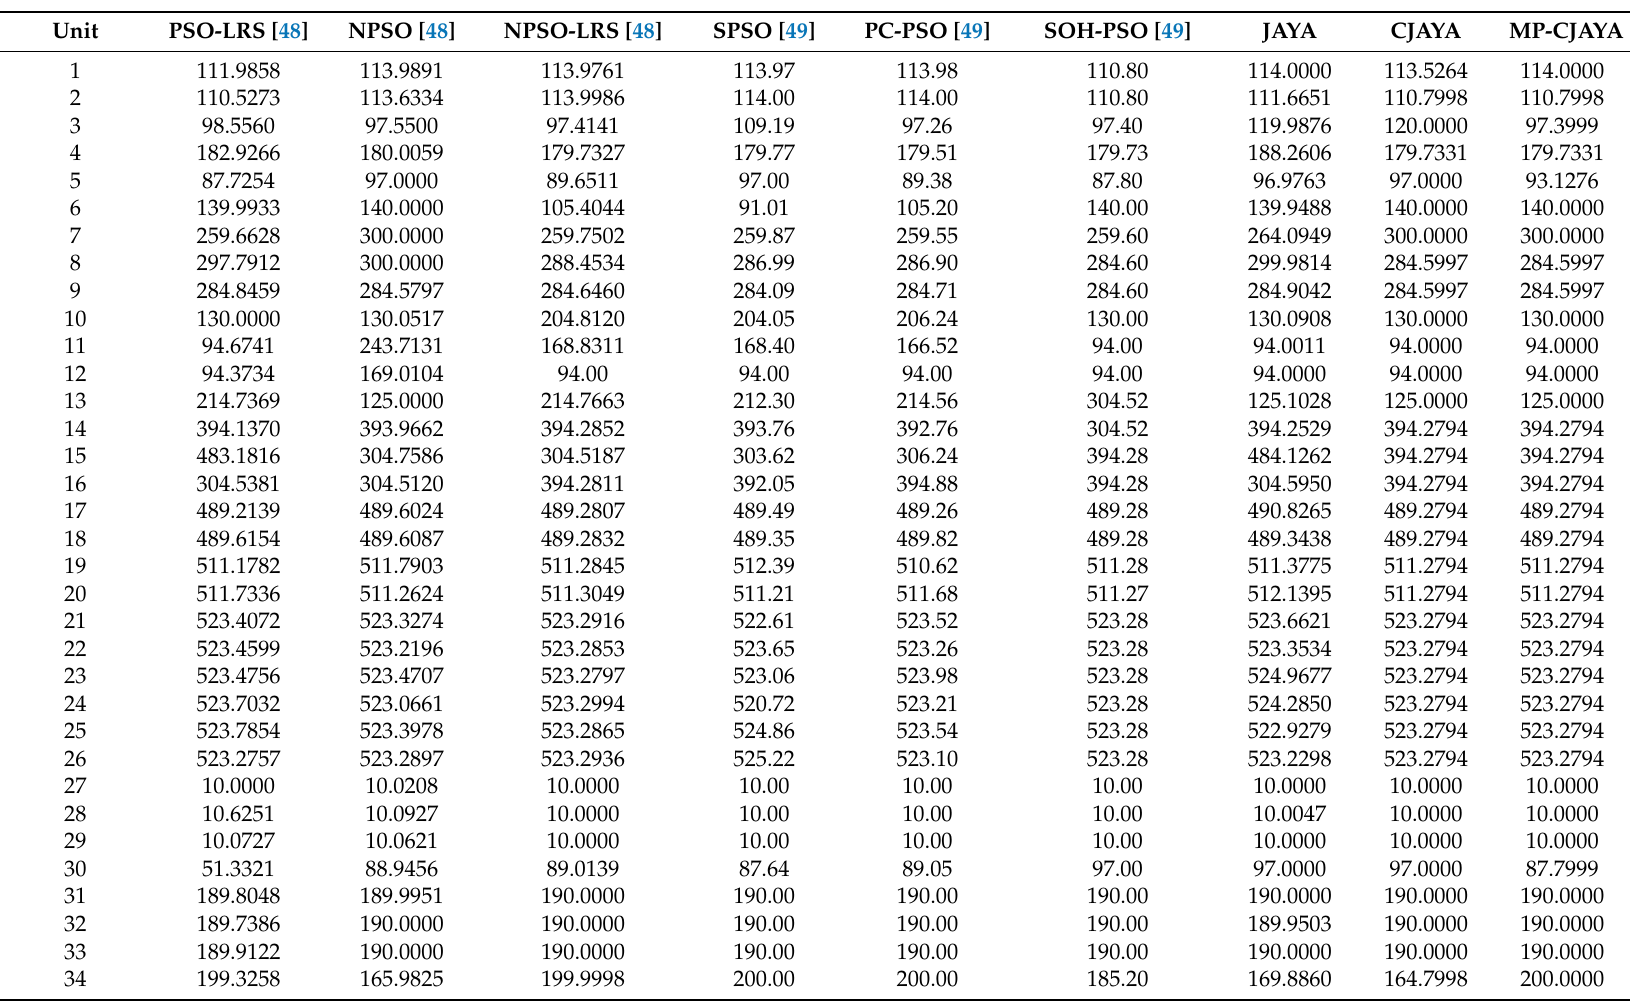
Table 4. Best outputs for 40-units system ( P D = 10,500